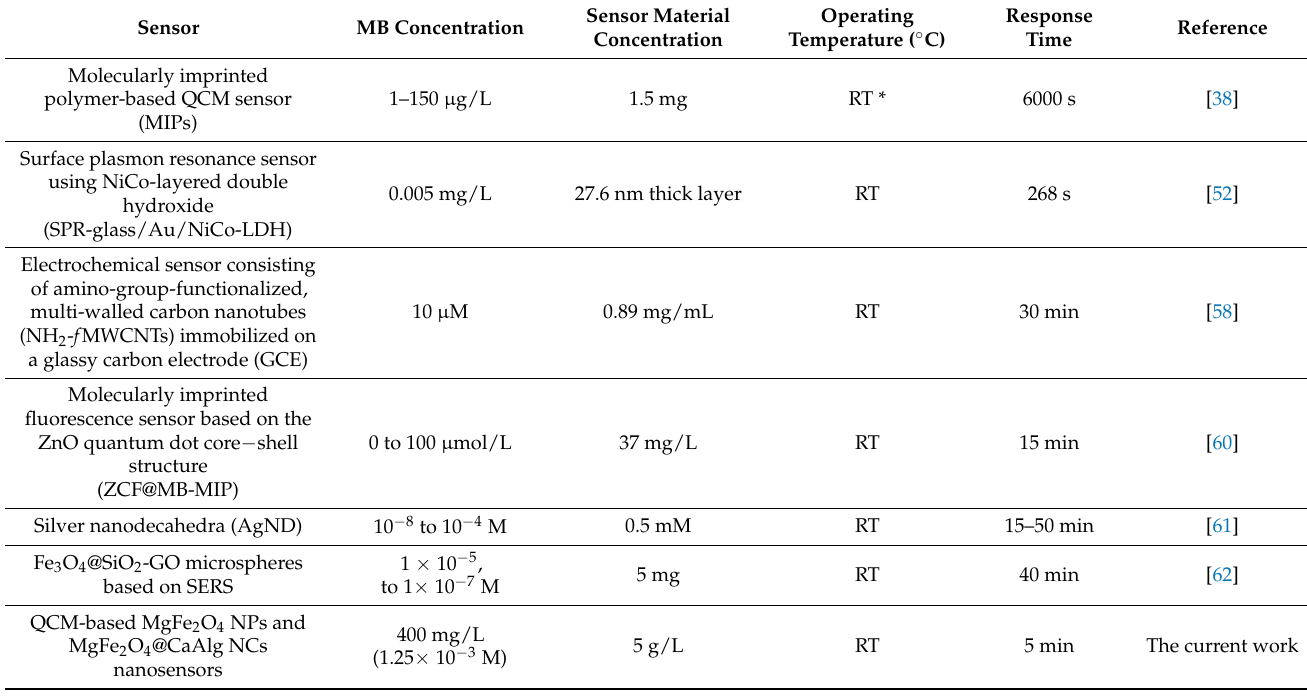
Table 2. Response sensitivity parameters of the different MB sensors based on sensing platforms in the literature compared with the QCM-based MgFe 2 O 4 NPs and MgFe 2 O 4 @CaAlg NCs